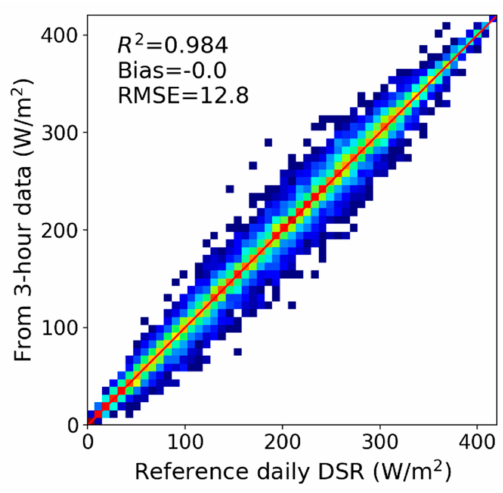
Figure 6. Comparison of the daily DSR values calculated from 3-h field measurements with the daily DSR reference data from the 1-min field